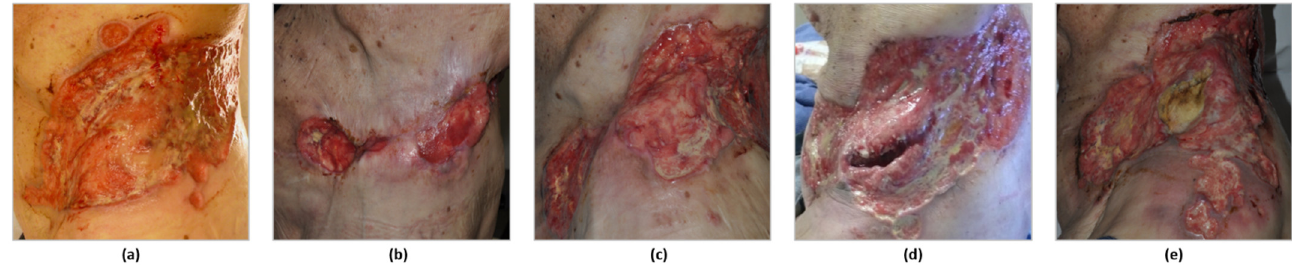
Figure 2. Exemplary photodocumentation of one patient during the course of treatment. Photodocumentation for patient 7 with locally advanced basal cell carcinoma along the treatment sequence HHI–PD1i–HHI. ( a ) Starting point before systemic treatment with locally advanced basal cell carcinoma on the left flank. ( b ) Initial partial response to vismodegib within 16 months of treatment, followed by ( c ) progressive disease under HHI after another 7 months. ( d ) Further progressive disease under cemiplimab within 6 months after only short term partial response. ( e ) Tumor stabilization was reached within 4 months under HHI reinduction with sonidegib.